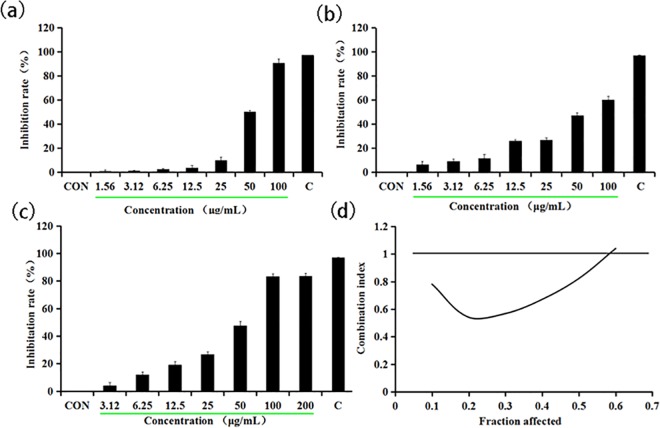
Quercetin combined with aconitine inhibit Hela cell proliferation.(a) Quercetin inhibits Hela cell proliferation. (b) Aconitine inhibits Hela cells proliferation. (c) Quercetin combined with aconitine inhibit Hela cells proliferation. (d) Median effect analysis of curcumin in combination with Q and A.